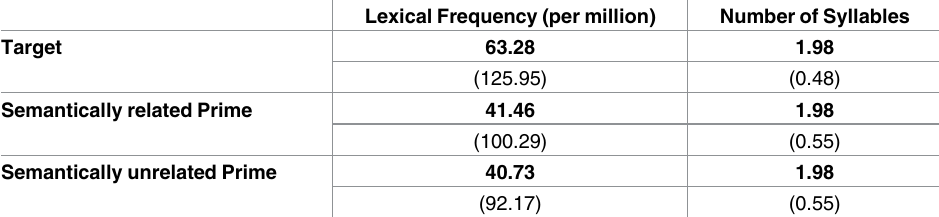
Table 1. Psycholinguistic characteristics of word